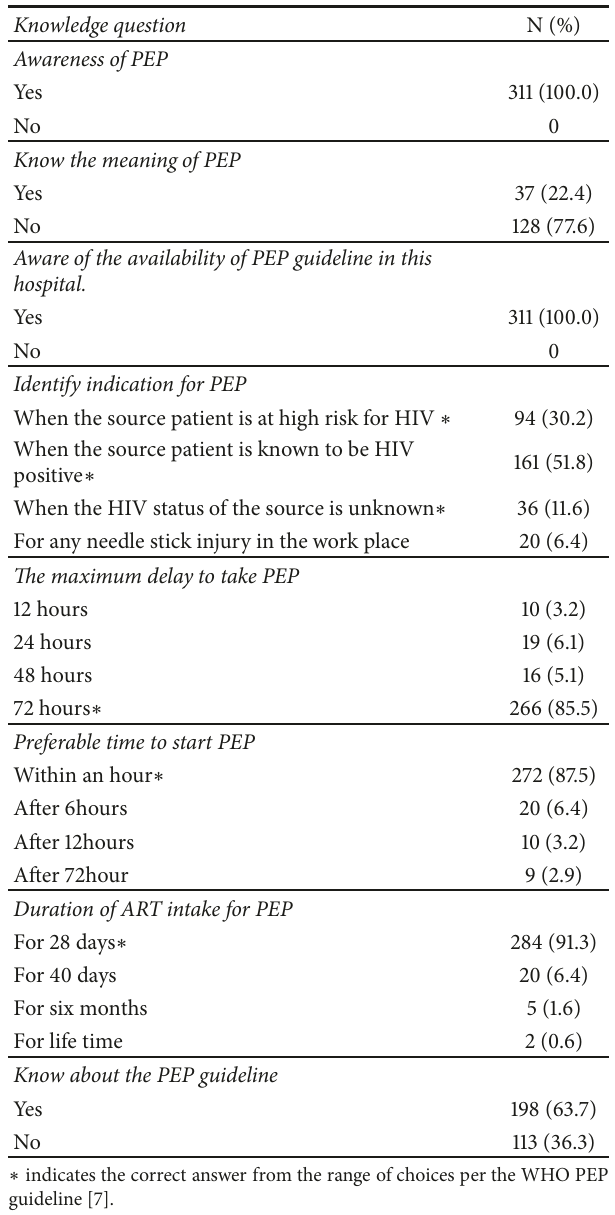
Table 3: Attitude of HCWs about PEP at Hiwot Fana Specialized University Hospital,